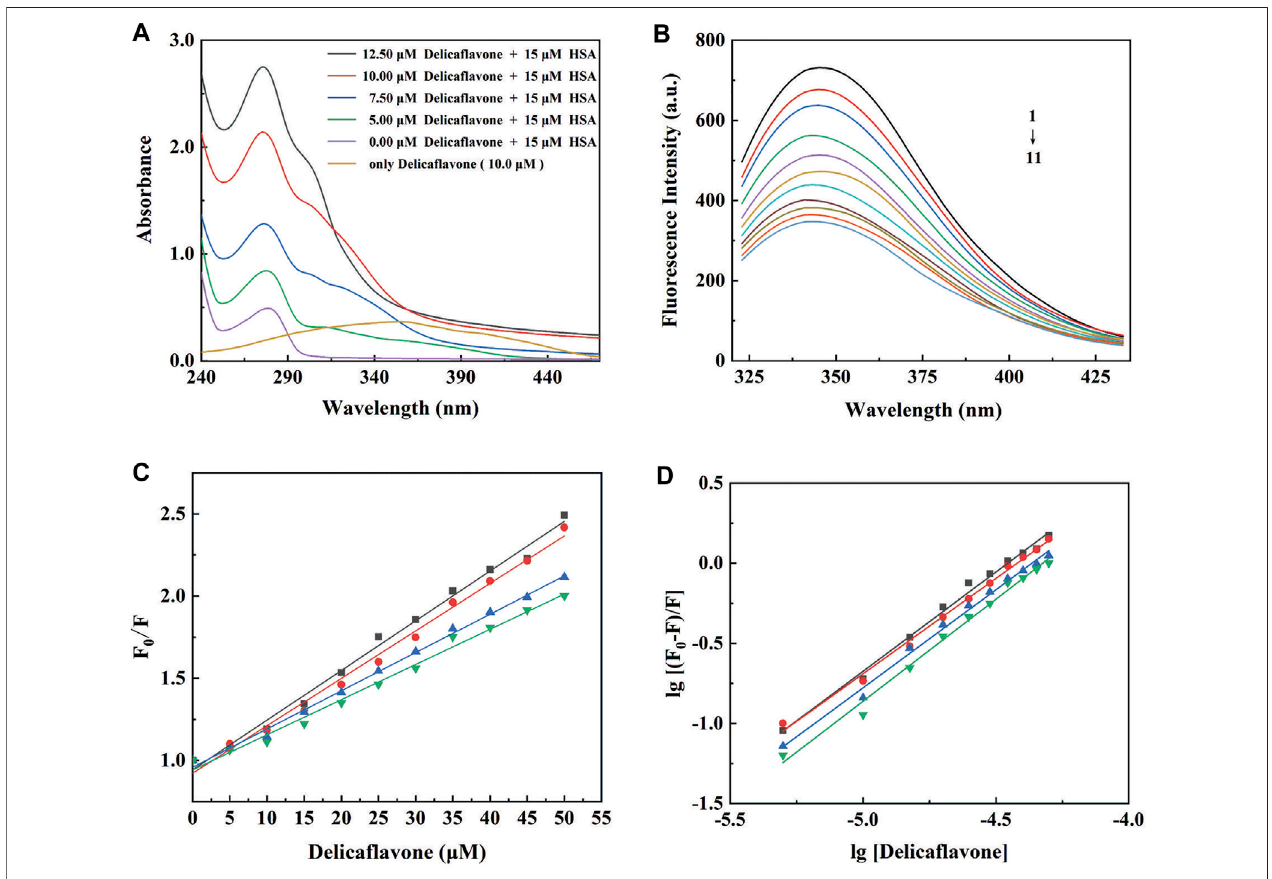
FIGURE 4 | (A) UV-visible absorption spectra of DF (0, 5, 7.5, 10, and 12.5 μ M) in the absence (purple line) or in the presence of HSA (15 μ M) at pH 7.4; (B) The intrinsic fl uorescencespectraofHSA (8 μ M)intheabsence(1)and presenceof5(2),10(3),15(4),20(5),25(6),30(7),35(8),40(9),45(10),and 50(11) μ MDF; (C) The Stern-Volmer plots and (D) the modi fi ed Stern-Volmer plots for fl uorescence quenching of HSA (8 μ M) by DF at 298 ( ■ ), 303 ( C ), 308 ( ▲ ), and 313 ( ▼ ) K.